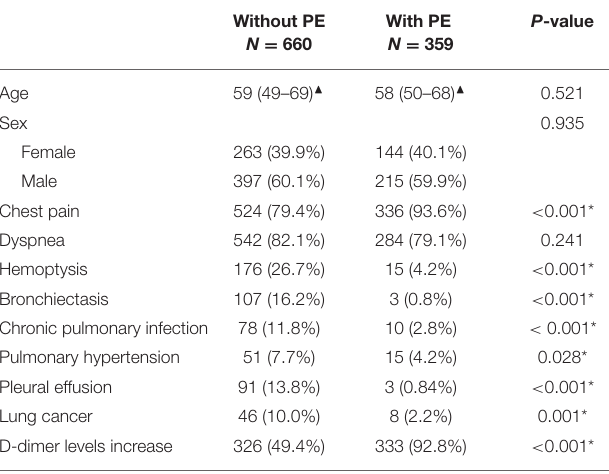
TABLE 1 | Clinical characteristics of patients with PE and without